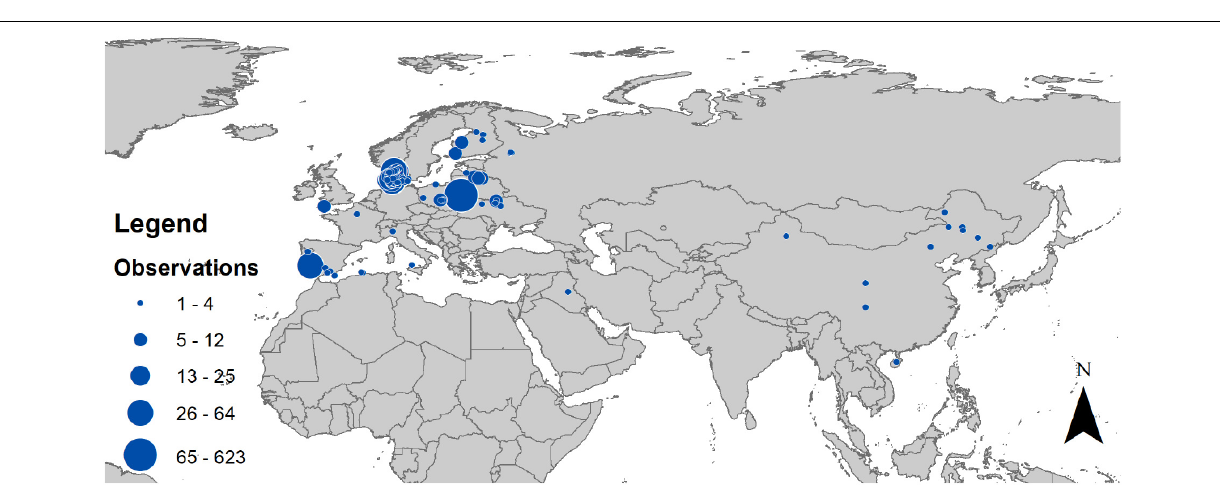
communist countries and Western European